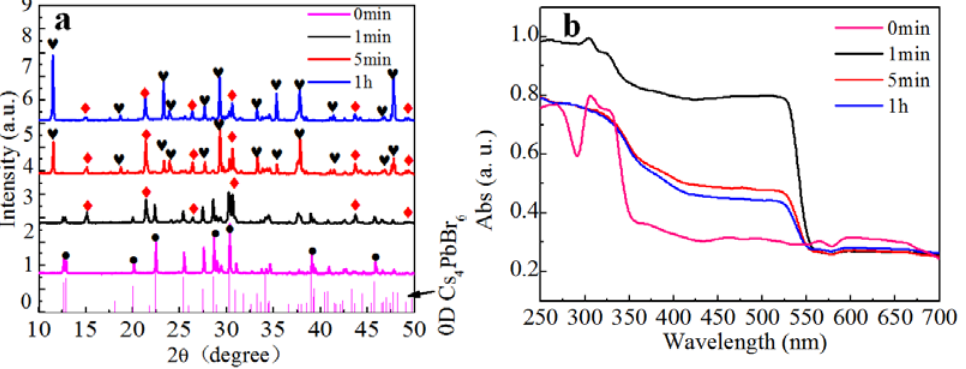
Figure 3. ( a ) PXRD pattern of Cs 4 PbBr 6 solids after water treatment for different time, the red diamonds represent CsPbBr 3 , the black hearts represents CsPb 2 Br 5 , the black dots represents Cs 4 PbBr 6 ; ( b ) Absorption spectra of PXRD pattern of Cs 4 PbBr 6 solids after water treatment for different times.